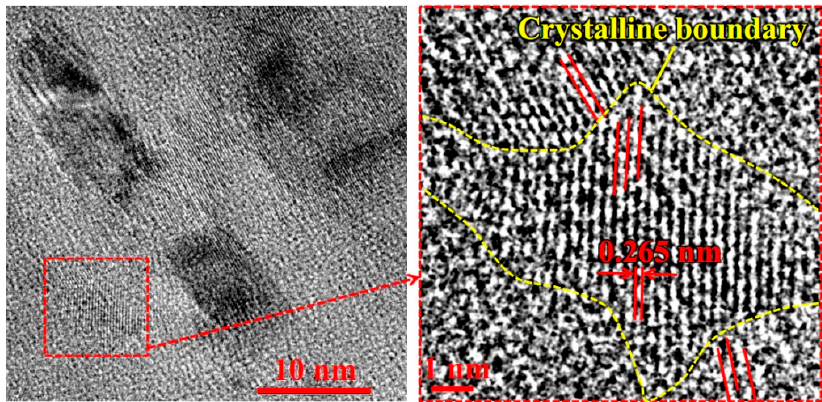
Figure 8. The wear-resistant (Ti,Al,Si)N layer of the coating (at S4) (TEM).